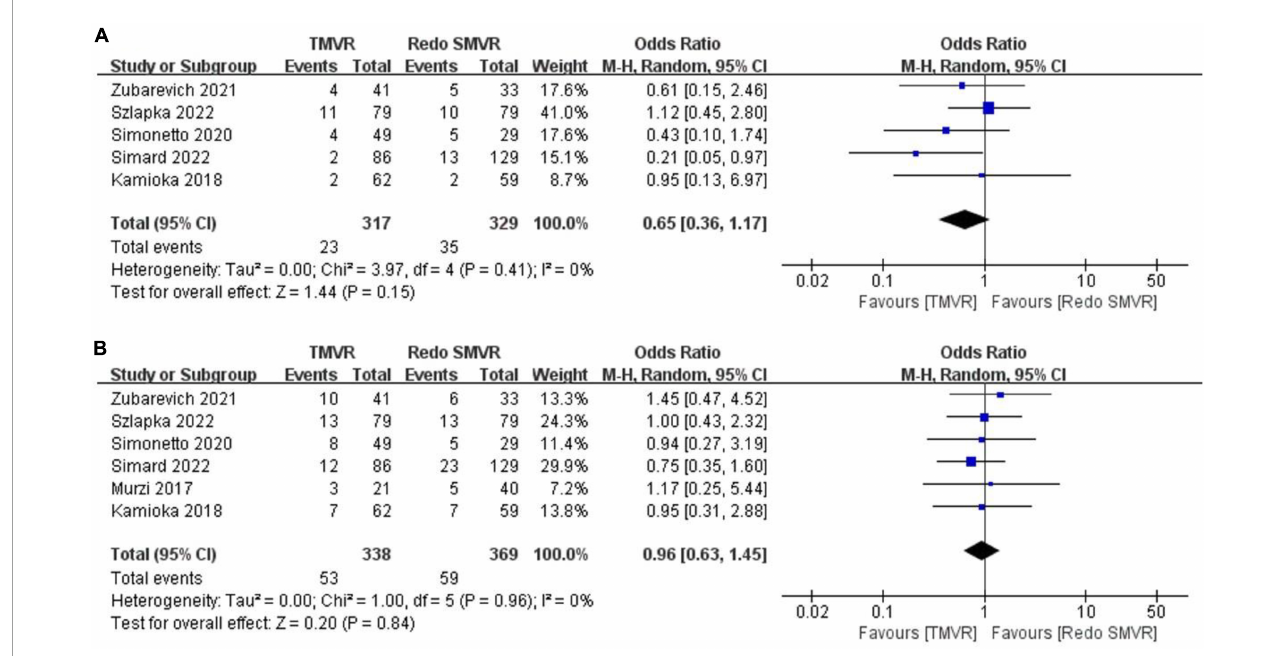
FIGURE5 Forest plot comparing TMVR with redo SMVR for (A) 30-day mortality and (B) 1-year mortality. CI, confidence interval; df, degrees of freedom; MH,